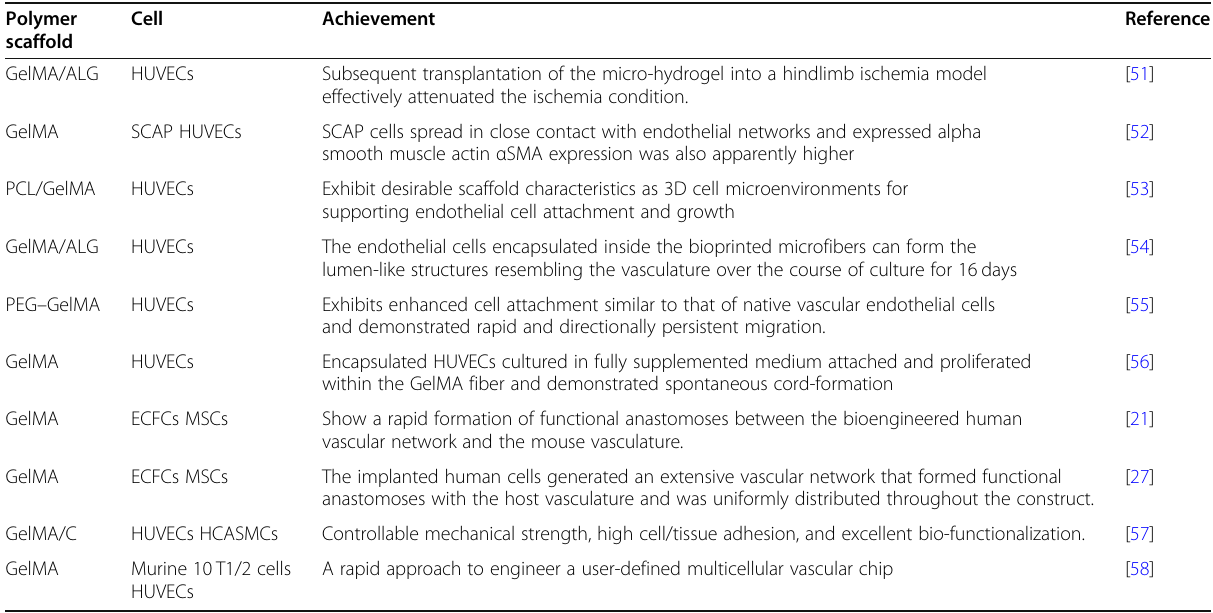
Table 1 The recent application of GelMA in neovascularization Polymer scaffold